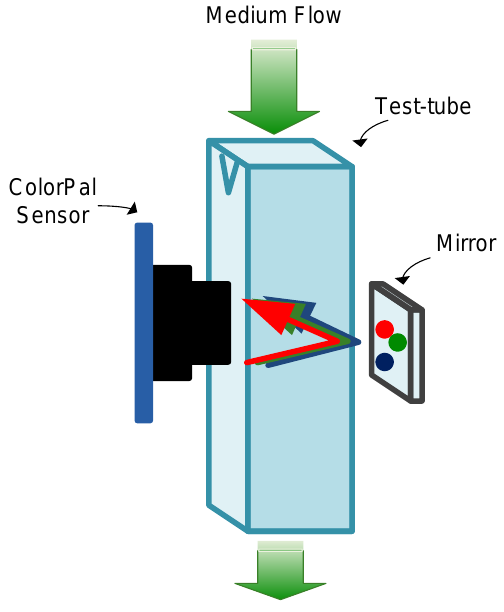
Figure 3. Sketch of the sensing